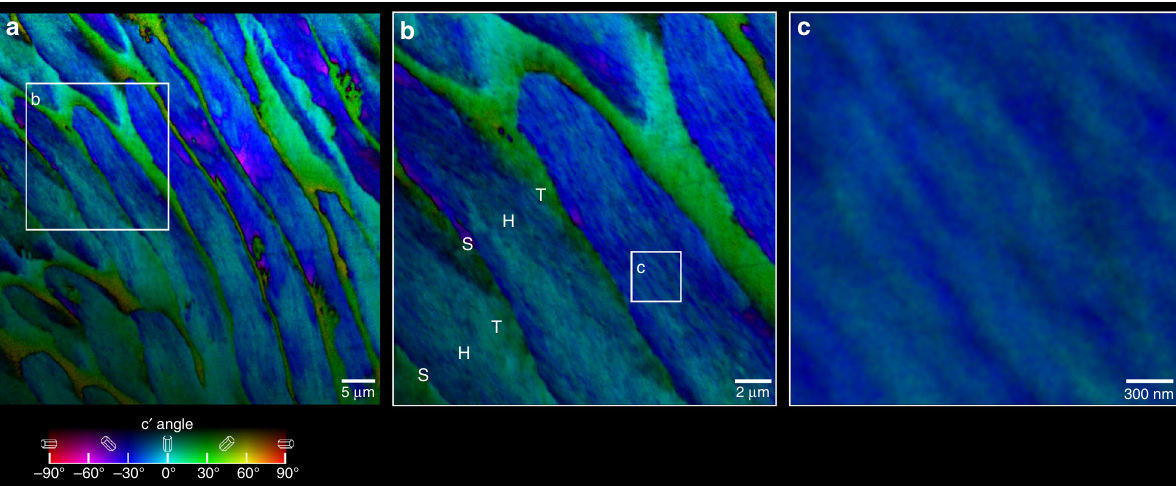
Fig. 1 PIC maps revealing the hidden crystal orientation structure of inner enamel. a Low magni fi cation map of polished cross-section of human enamel (see Supplementary Fig. 3 for the position of this area in the enamel polished cross-section). Notice the ~5 µ m wide rods with a signi fi cant number of crystal c -axes oriented along the rod axis (blue). However, many other crystals are oriented ±30° off the rod axis (cyan and magenta). The c -axes of interrod crystals are highly co-oriented, as evident from the homogeneously green hue ( + 30° from the vertical in the lab and in this image) almost everywhere, with just a few orange pixels ( + 60°). b Zoomed-in PIC map acquired in the correspondingly labeled box in a , showing the fi ne details of the rod and interrod crystal orientation and arrangement. Notice in b that the transitions in crystallographic orientations between a rod head (H) and its interrod tail (T) is gradual, whereas the transition from the interrod to the next rod ’ s head is abrupt and these are separated by an organic sheath (S). c Zoomed-in region in b , where individual crystals inside the rod are parallel to each other but their c -axes are not co-oriented, thus single or multiple co- oriented crystals stand out as different colors, e.g. blue surrounded by cyan or vice versa. Typical crystal width is ~50 nm, resolution and pixel size are both 22 nm in b and c , and 60 nm in a